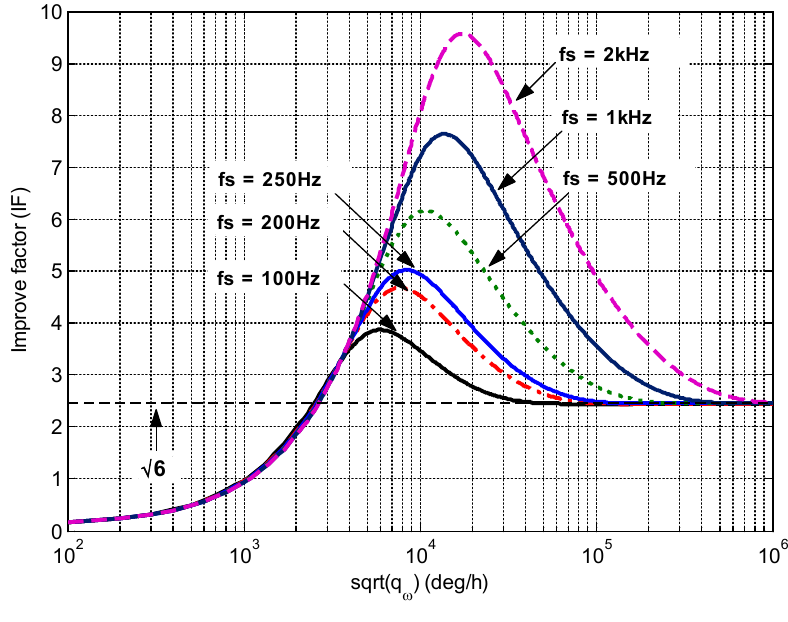
Figure 5. Plot of improvement factor versus different values of q sampling rates f s = 100, 200, 250, 500, 1000, 2000, 3000 Hz.